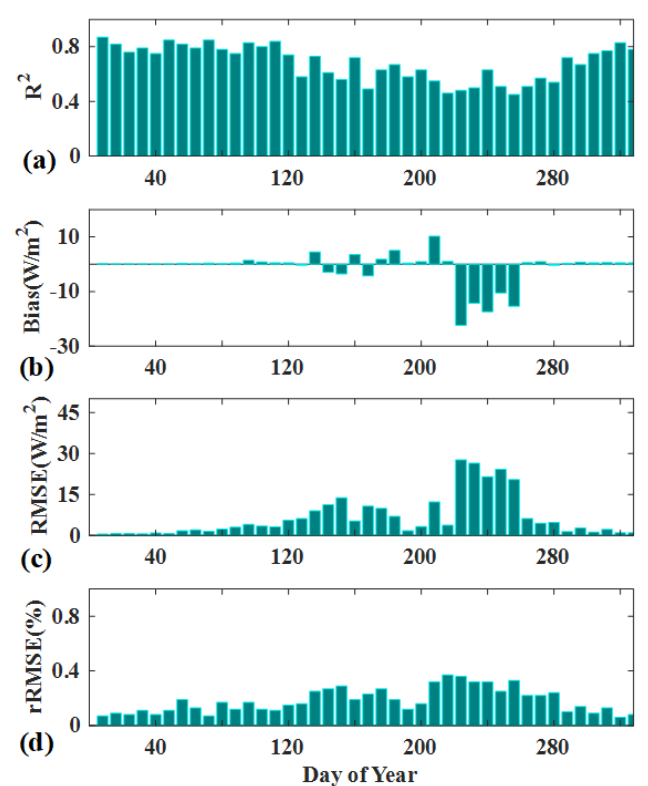
Figure 9. Comparisons of fused LE against MODIS LE when aggregate to MODIS gird. ( a ) R 2 , ( b ) bias, ( c ) RMSE, ( d ) rRMSE.